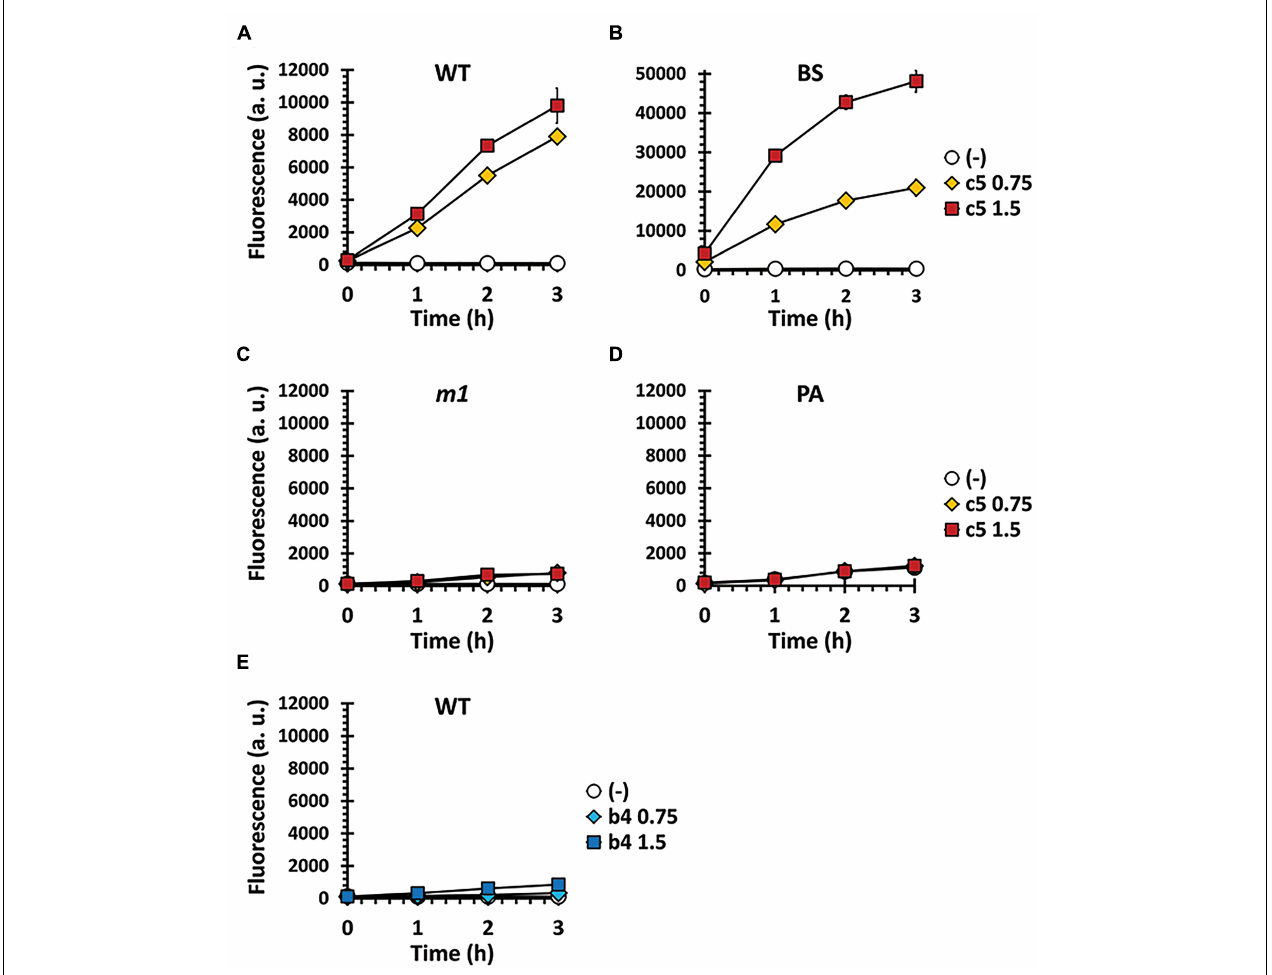
FIGURE 6 | ROS formation by c5 under aerobic condition. ROS generation was measured in SA3 (WT) (A,E) and its mutant ( m1 ) (C) as well as in B. subtilis (BS) (B) and P. aeruginosa (PA) (D) , which had been grown to the logarithmic growth phase in M9 minimal medium containing 0.75 (diamond) or 1.5 µ g/ml (square) of either c5 (A–D) or b4 (E) . No-compound controls (empty circle) were included to investigate the endogenous ROS generation. The data of three independent experiments were pooled and means are shown. Error bars represent standard deviations of the